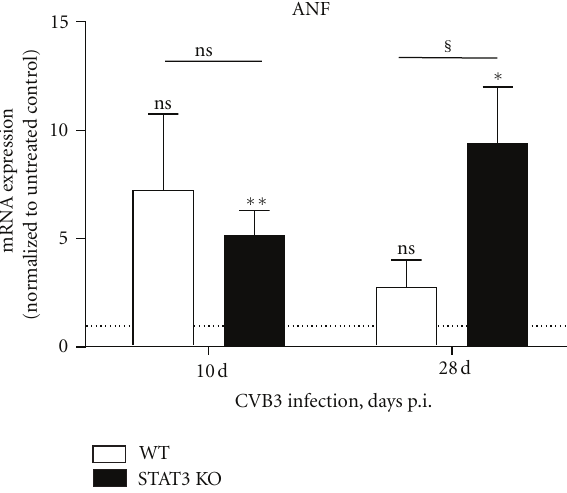
Figure 4: ANF expression in cardiac tissue of CVB3 infected mice. The mRNA expression level is shown 10 and 28 days after CVB3 infection of WT and STAT3 KO mice. The expression data are normalized to the house-keeping gene 18S and to the expression levels of the corresponding untreated mice and expressed as x-fold over basal expression using the formula 2 − ΔΔ Ct . ∗ Data were compared to the expression of the corresponding untreated controls. ∗ P < 0 . 05; ∗∗ P < 0 . 01. § Data between WT and STAT3 KO mice were compared. § P < 0 .